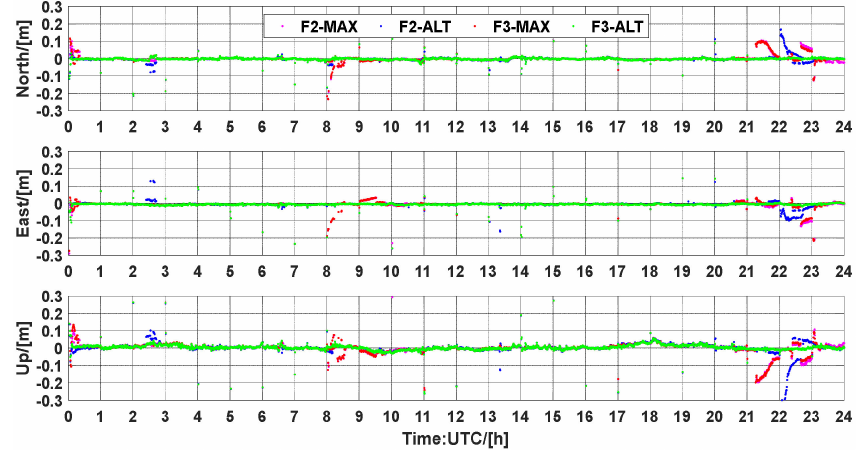
Figure 16. Position errors for UCPPP PAR using the atmospheric corrections from WARE station on DOY 082, 2021.